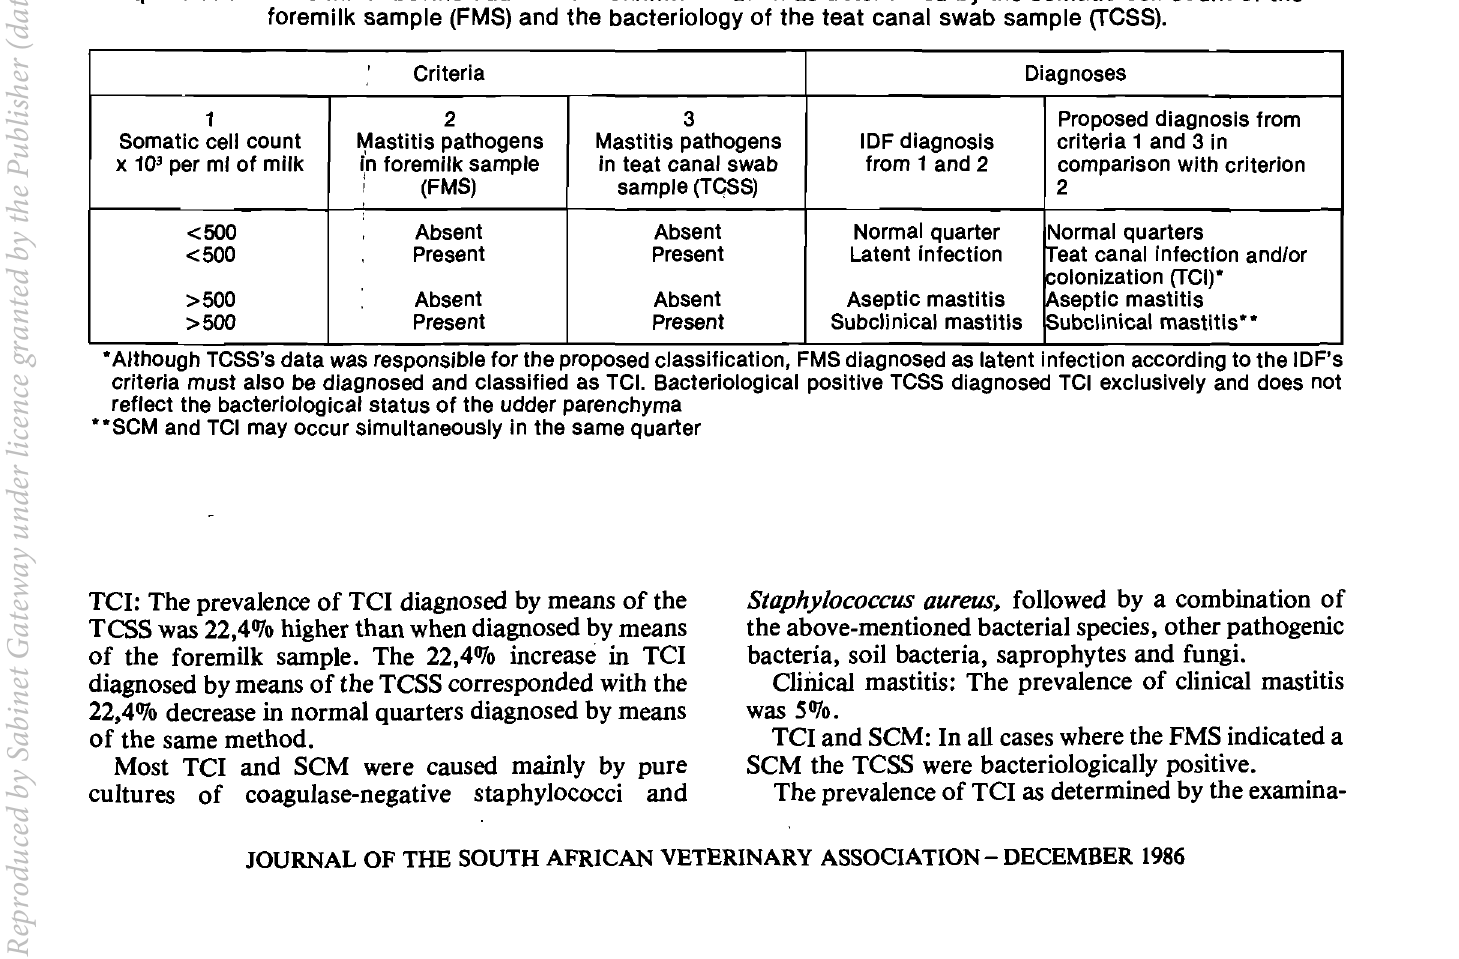
Table 2. The prevalence of normal quarters (N), teat canal infection/colonization (TCI), aseptic mastitis (ASM) and subclinical mastitis (SCM) diagnosed according to the results of the foremilk sample (FMS) and teat canal swab